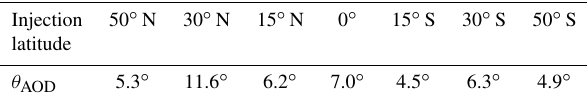
Table 3. Angle between the AOD vector of each high-altitude in- jection and the set of all low-altitude